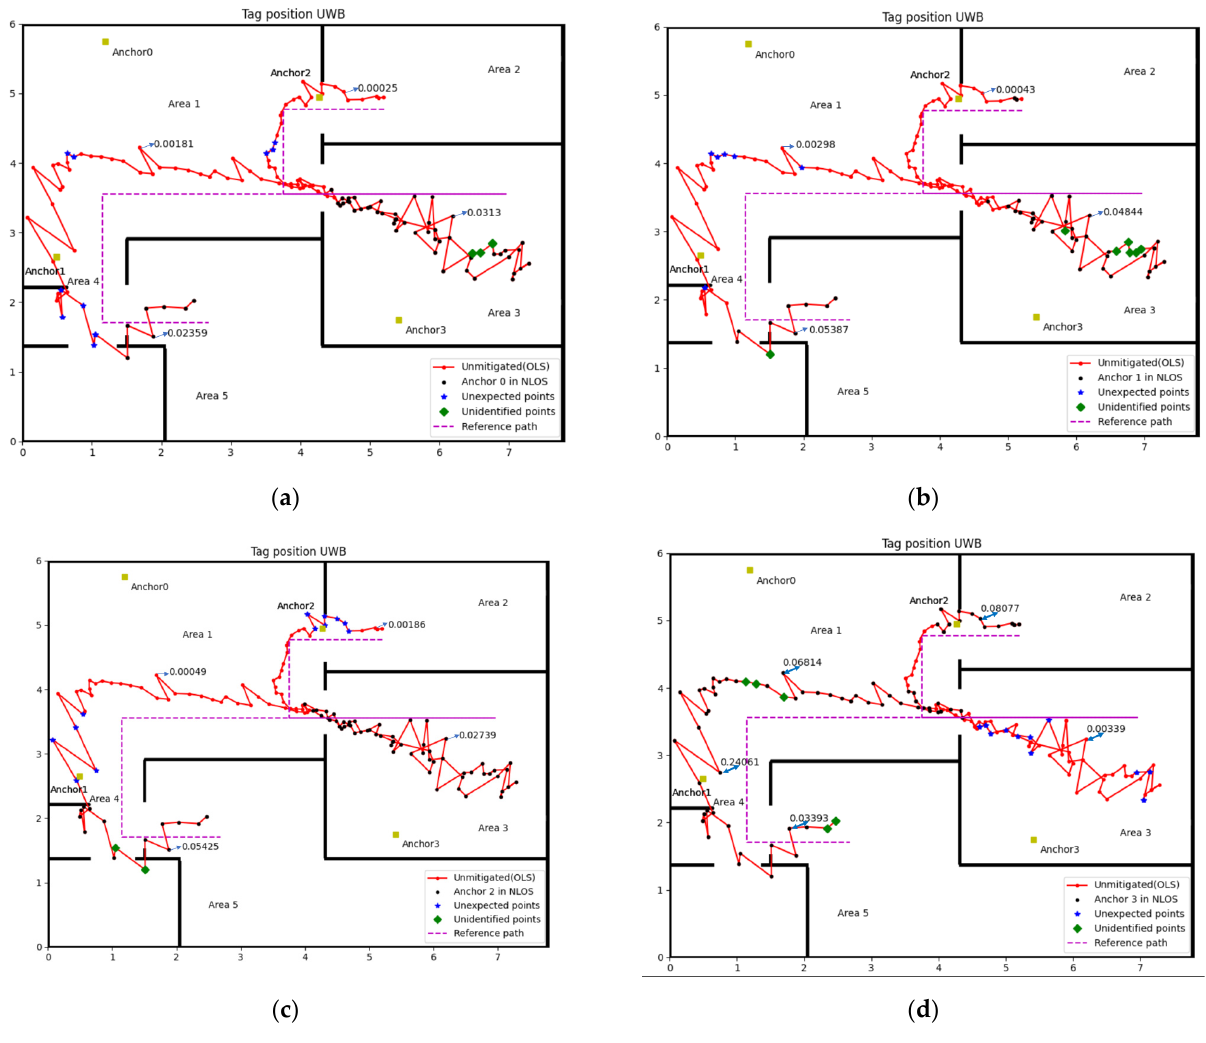
Figure 8. NLOS identification result (Experiment 2): ( a ) Anchor 0, ( b ) Anchor 1, ( c ) Anchor 2, ( d ) Anchor 3. Table 3. The accuracy rate of NLOS identification (Experiment